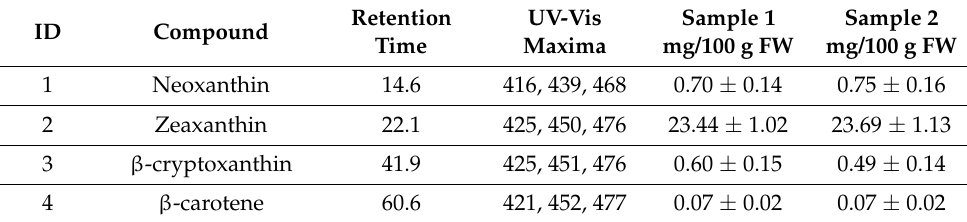
Figure 1. HPLC/PDA chromatogram of saponified Goji berries extract 2: 1-neoxanthin; 2-zeaxanthin; 3- β -cryptoxanthin; 4- β -carotene. Table 1. Carotenoids composition (mg/100 g FW +/ − SD) in the saponified Goji extracts.